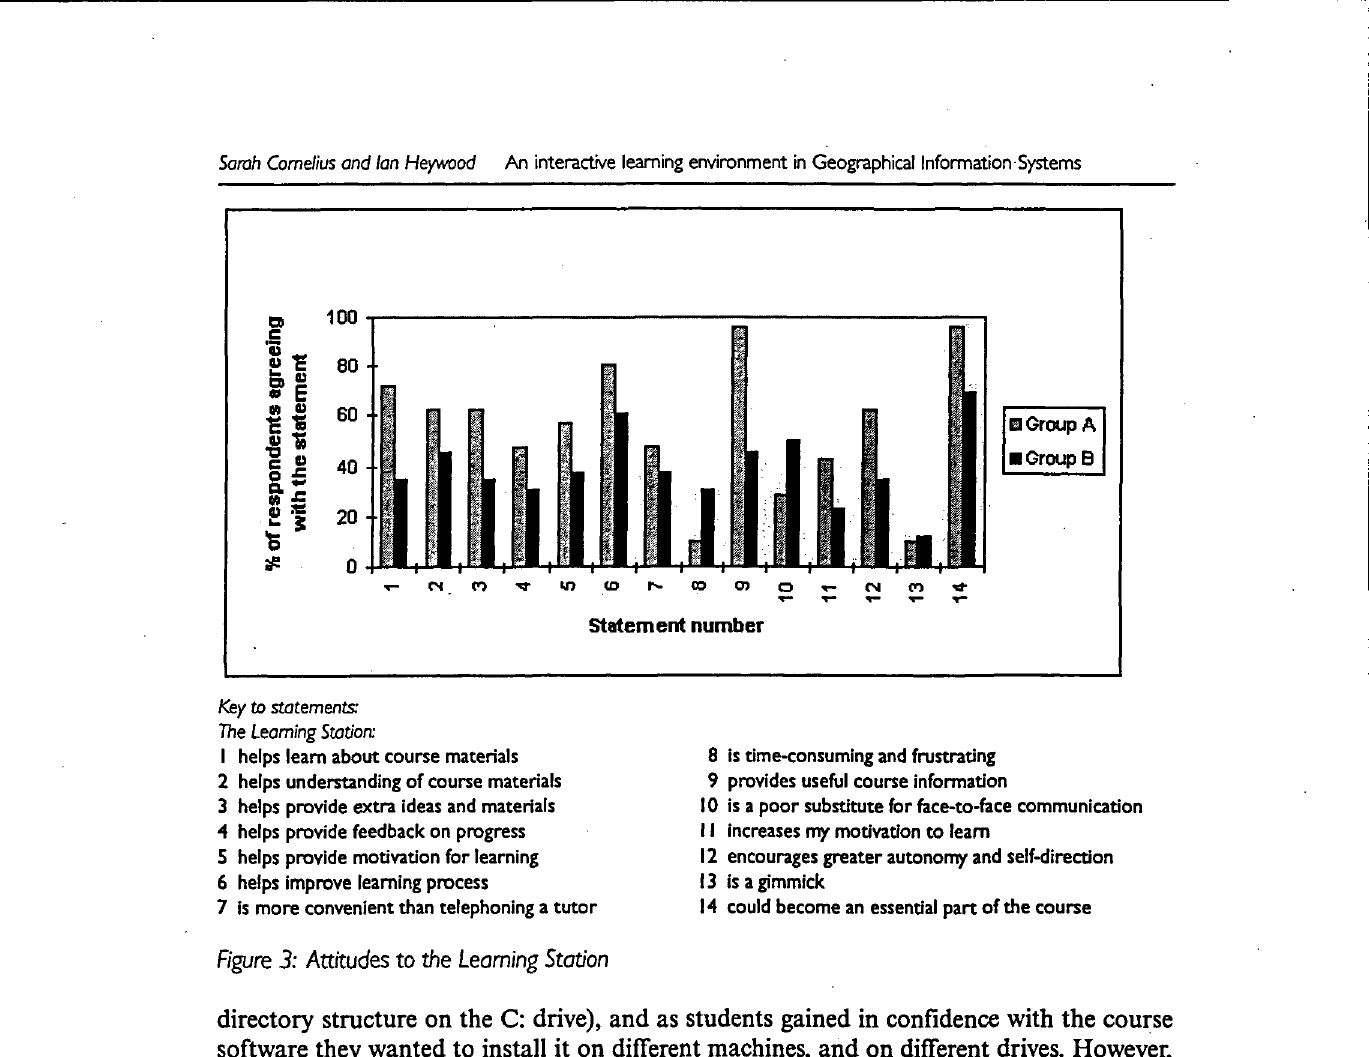
Figure 3: Attitudes to the Learning Station